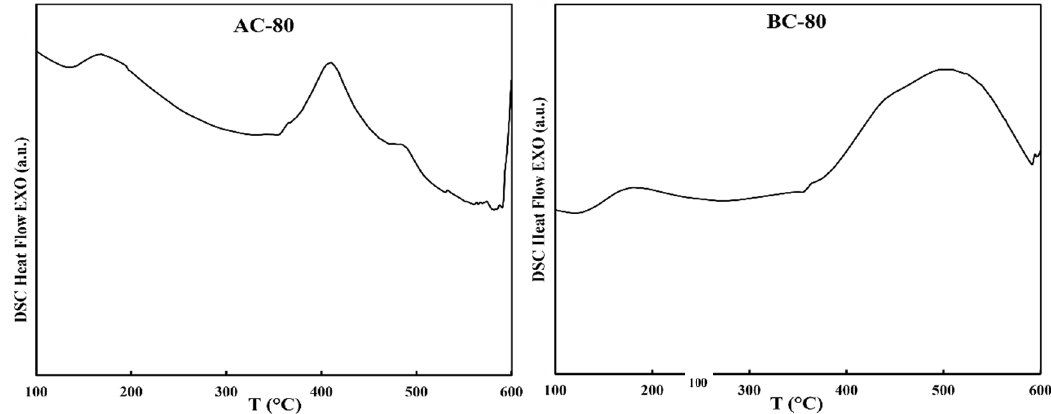
Figure 6. DSC curves of the compacted specimens AC-80 and BC-80.